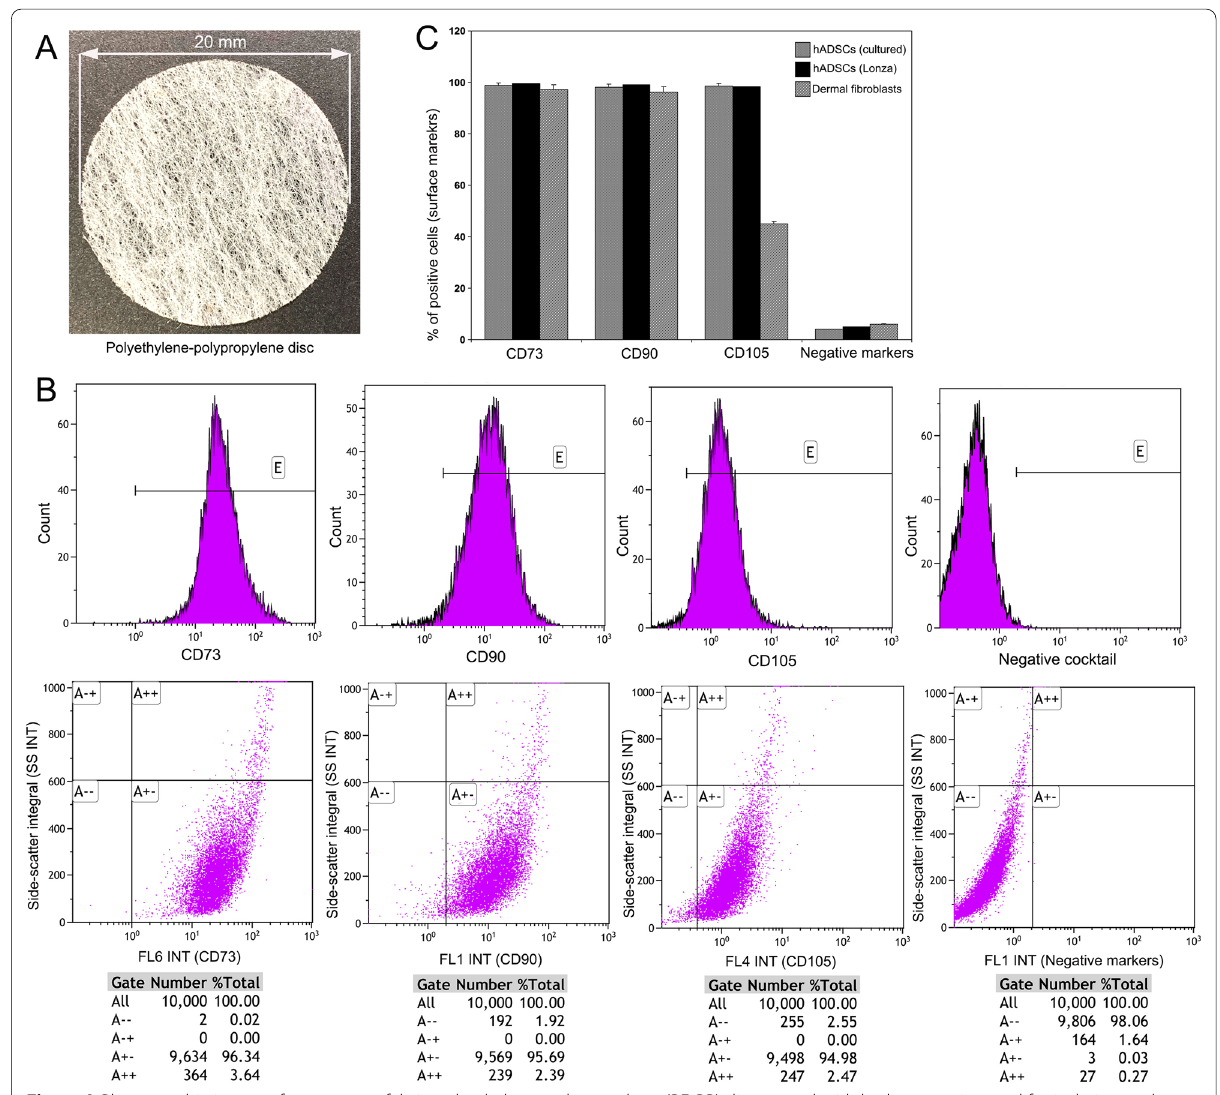
Fig. 1 A Photographic image of non-woven fabric polyethylene-polypropylene (PE-PP) disc coated with hydroxyapatite used for isolation and culture of human adipose tissue derived stem cells (hADSCs) without enzymatic digestion. B Representative histogram and dot plot images of the flow cytometric analysis of isolated and cultured hADSCs (2nd passage) for the expression of CD73, CD90, and CD105 and a cocktail of negative markers (CD34, CD11b, CD19, CD45, and HLA-DR) after harvested using Accutase cell detachment solution and treatment with respective anti-human mAbs conjugated with various fluorescent tags. The gated cells in A —column indicates they are positive for the respective surface + marker and the cells in A– column indicates that the negative markers are not expressed in hADSCs. Practically no cells are present in A —column + with the expression of negative markers. C Graphical presentation of the flow cytometry data for the expression of surface markers in cultured hADSCs, human ADSCs from Lonza, and human dermal fibroblast cells. The data are mean S.D. of 5 independent ±